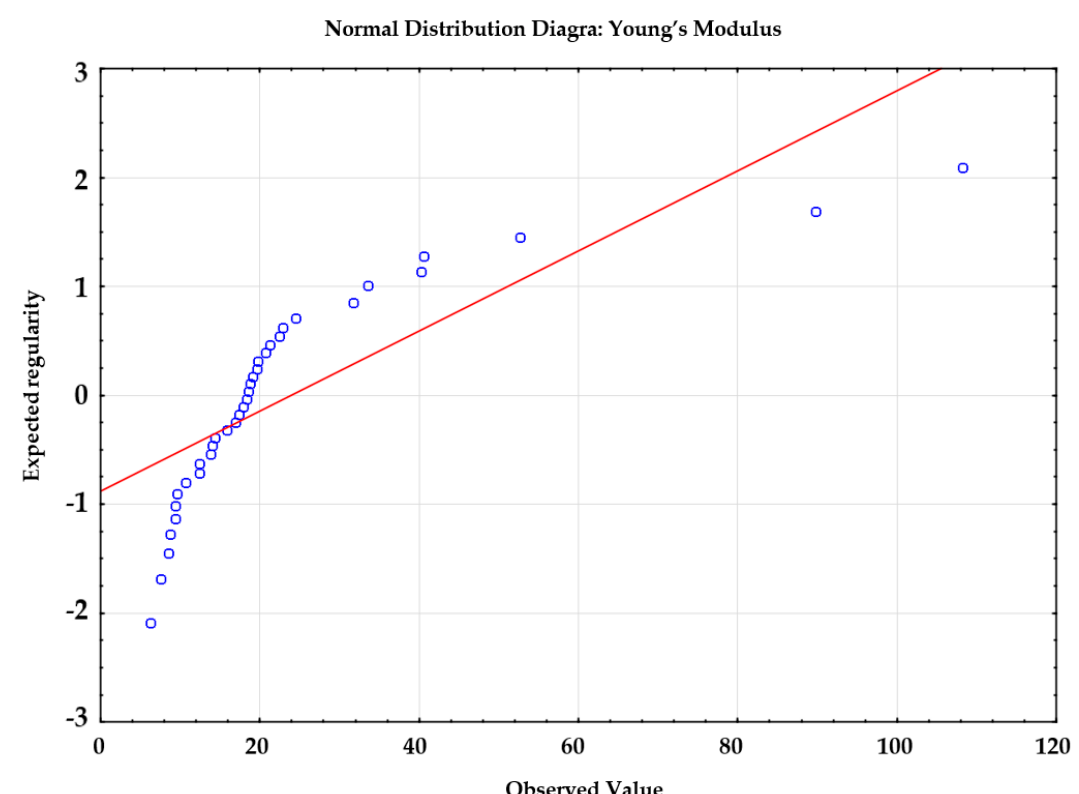
Figure 8. Graphic interpretation of the interaction effect.